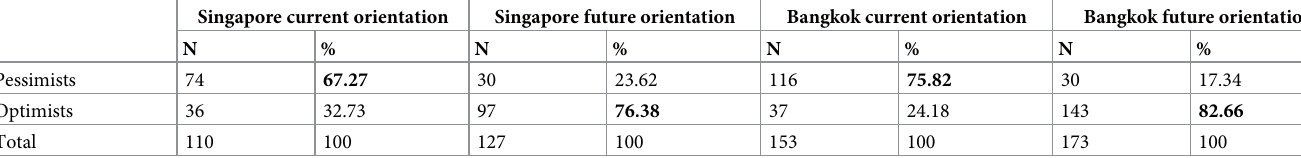
Table 3. Optimists/Pessimists distribution by location and time orientation.